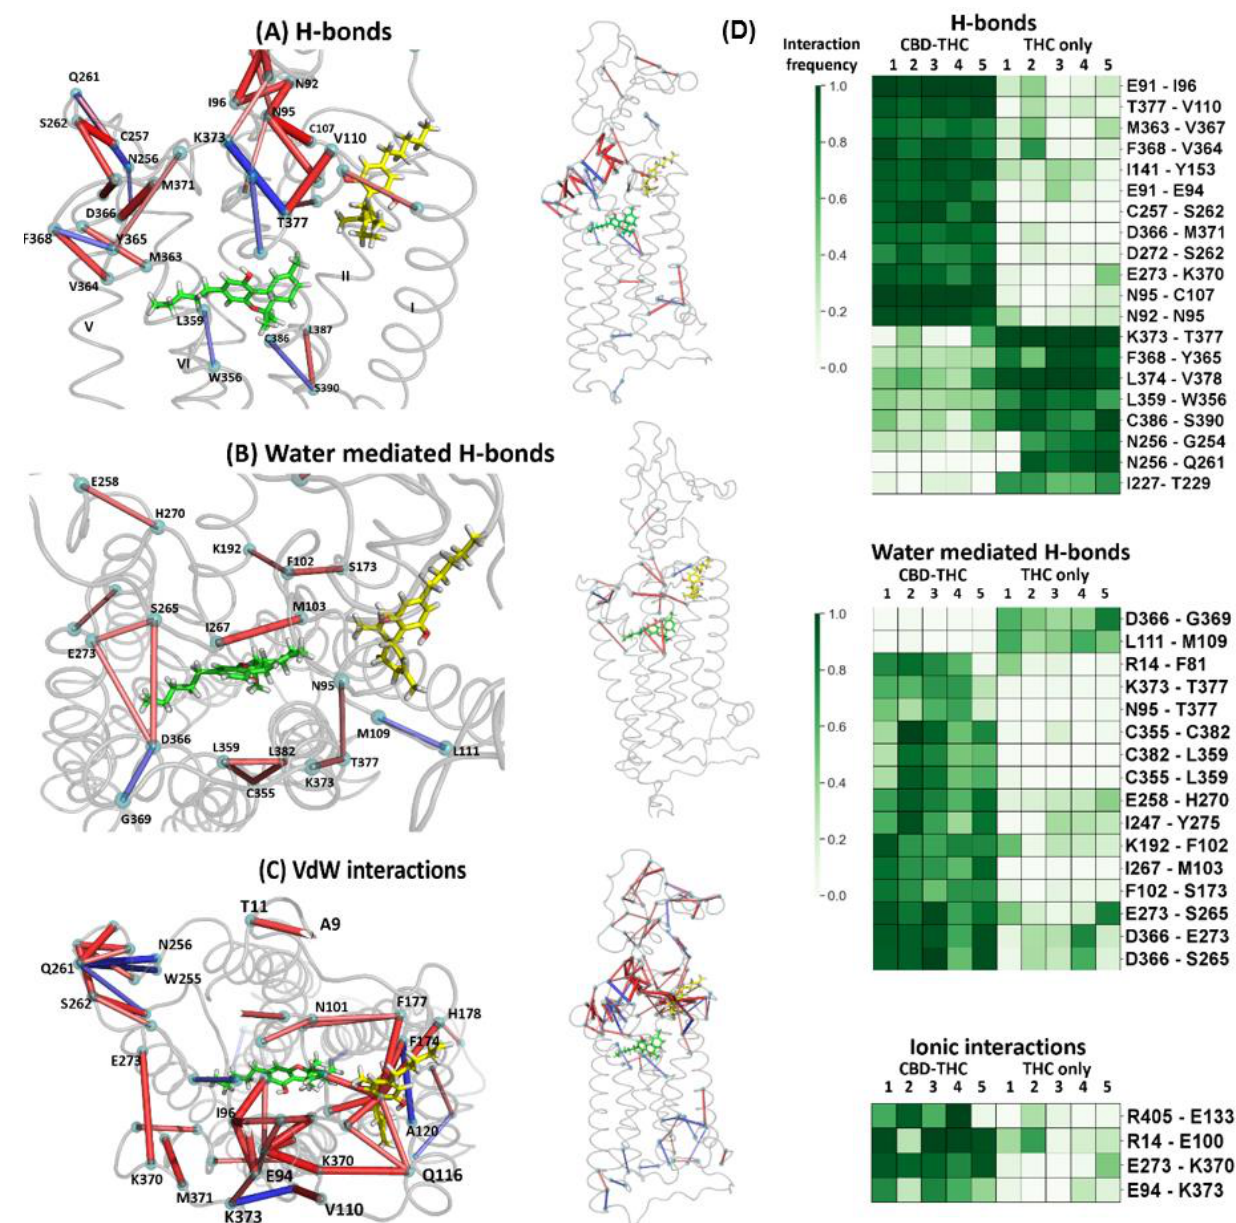
Figure 13. Differences in contact frequencies between CBD-THC and THC-only complexes; ( A ) Hydrogen bonds—both side views; ( B ) Water mediated hydrogen bonds—the extracellular and side view; ( C ) van der Waals interactions—the extracellular and side view. Red sticks represent contacts occurring more frequently for CBD-THC simulations, and blue ones are the contacts occurring more frequently in THC-only simulations. The thickness of a stick as well as a color intensity correspond to the average frequency difference between those two populations of trajectories; ( D ) The interaction frequency fingerprints for CBD-THC and THC-only complexes (5 simulations for each complex). Presented interactions are very likely participating in the allosteric-orthosteric communication network since their frequencies differ significantly between simulations with and without an allosteric ligand (CBD). Among all possible interactions only the hydrogen bonds, water mediated hydrogen bonds, and ionic interactions are shown.